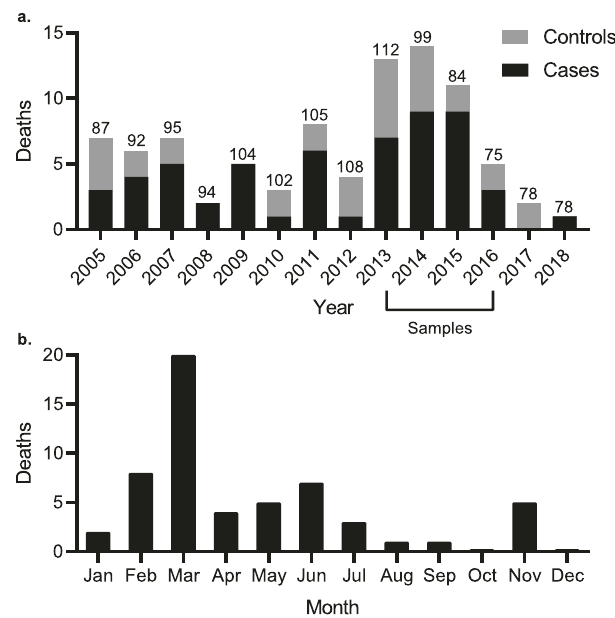
Fig. 2 Deaths attributed to epizootic neurologic and gastroenteric syndrome (ENGS) at Tacugama Chimpanzee Sanctuary from 2005 through 2018. a Annual chimpanzee deaths from ENGS (black, overall total = 56) and other causes (gray, overall total = 32). Numbers above the bars indicate the yearly total chimpanzee population and the horizontal bracket below the x -axis denotes the period during which we obtained samples for analysis. b Summed totals of ENGS fatalities by month over 2005 ‒ 2018 ( n = 56). Source data are provided as a Source Data fi le.